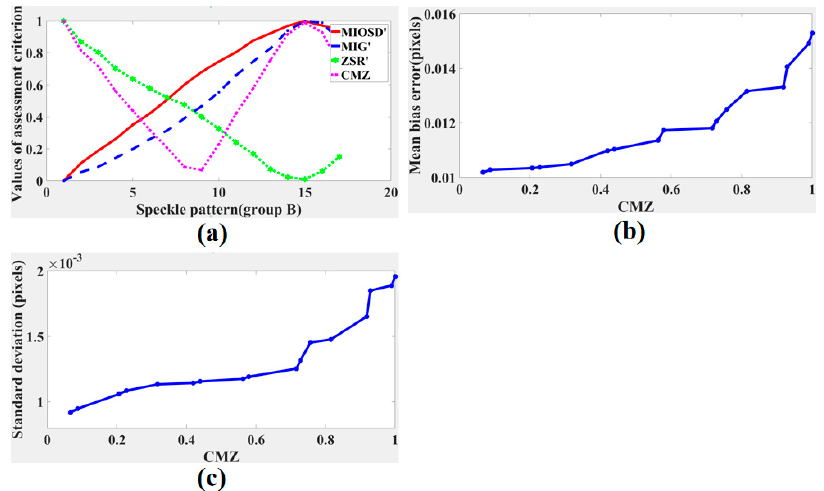
Figure 9. ( a ) Results of speckle patterns in group B: ( a ) assessment criteria, ( b ) mean bias errors with different CMZ values, and ( c ) standard deviations with different CMZ values.